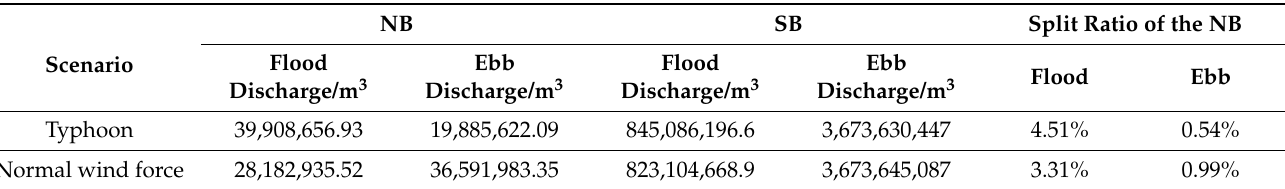
Table 3. Flood and ebb discharge of the NB and the SB, and the flow split ratio of the NB under two scenarios of Typhoon Fongwong and normal wind